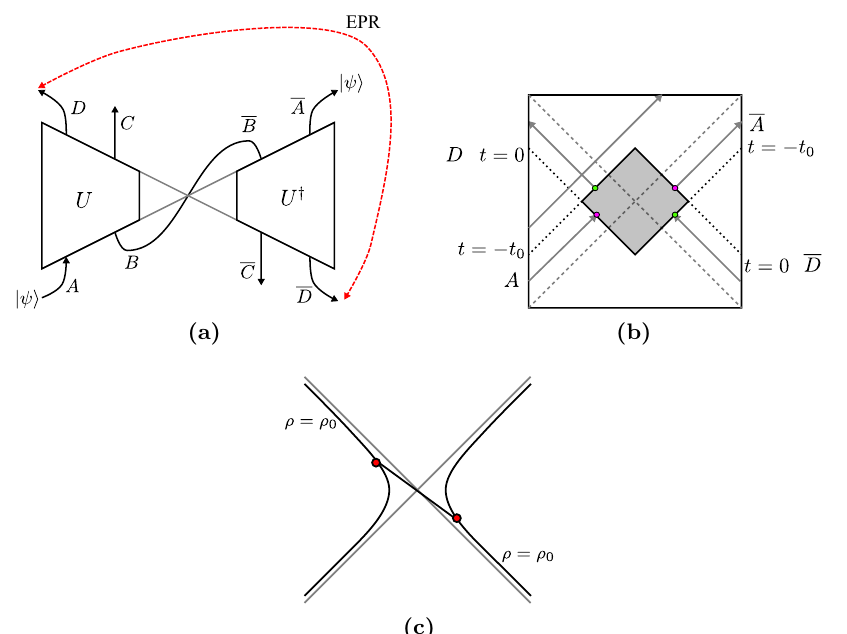
Figure 15 . (a) The Hayden-Preskill recovery protocol. (b) Backreaction from the Hayden-Preskill recovery. (c) Alice’s quantum (cid:12)eld theory near the horizon. Two surfaces in the opposite regions are